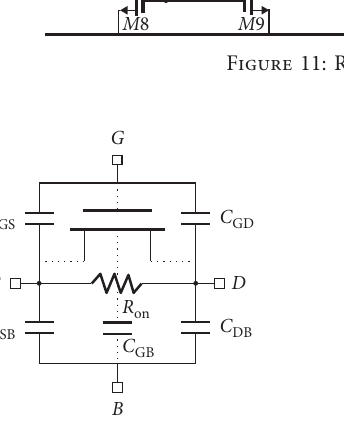
Figure 12: Equivalent diagram of the power